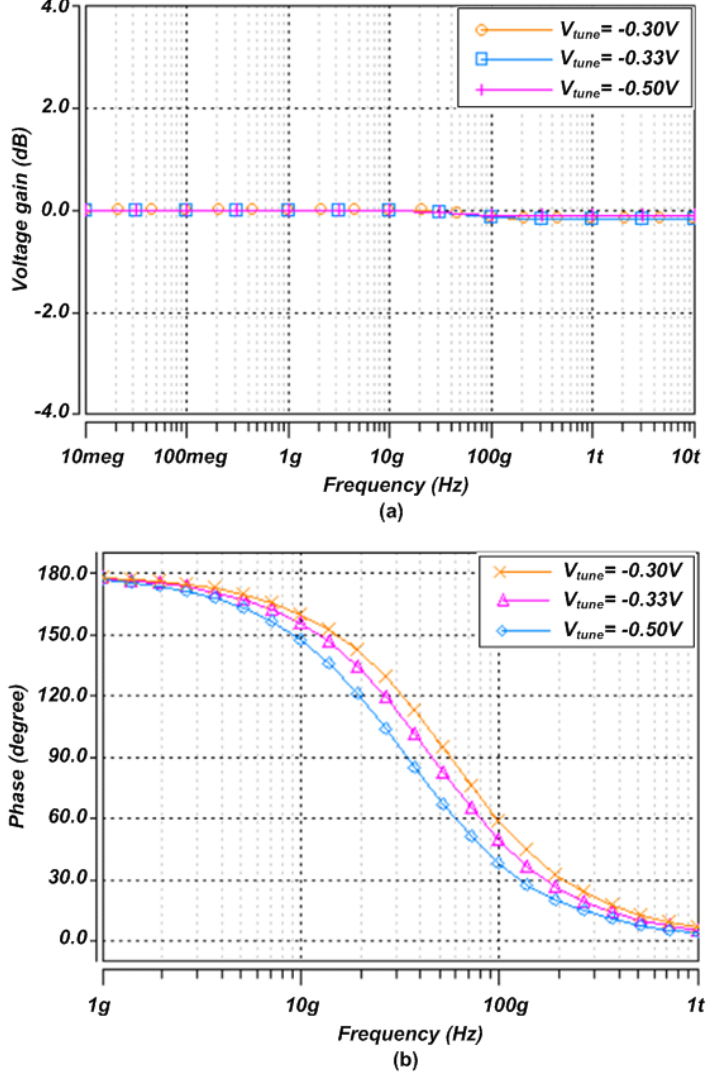
Figure 14. Frequency-response of AOTAPF at different values of V tune : ( a ) Voltage gain; ( b )